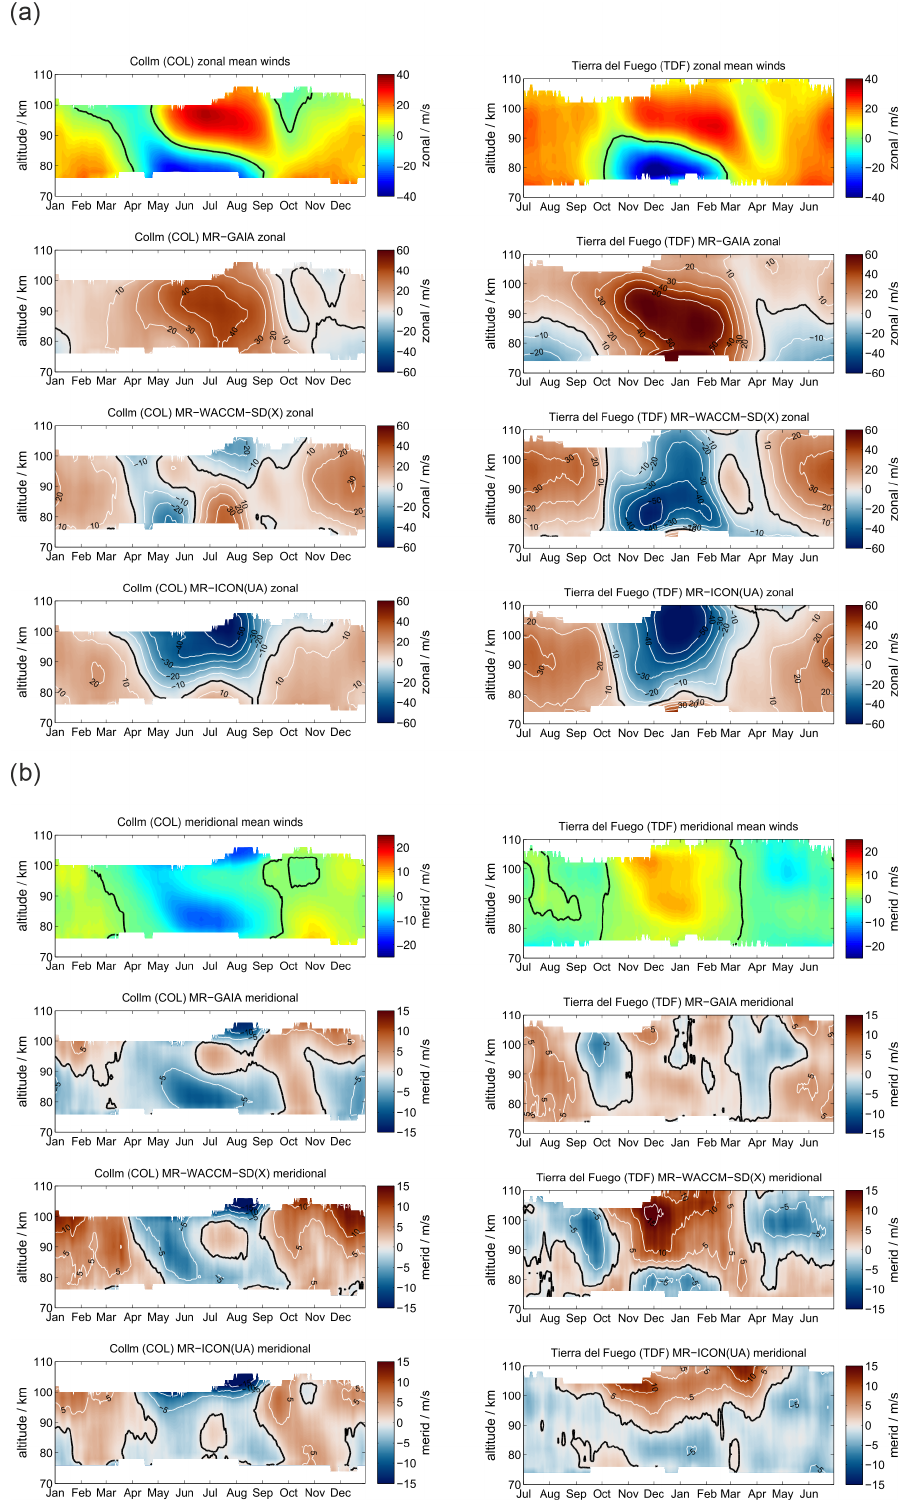
Figure B2. The same as Fig. B1, but for COL and